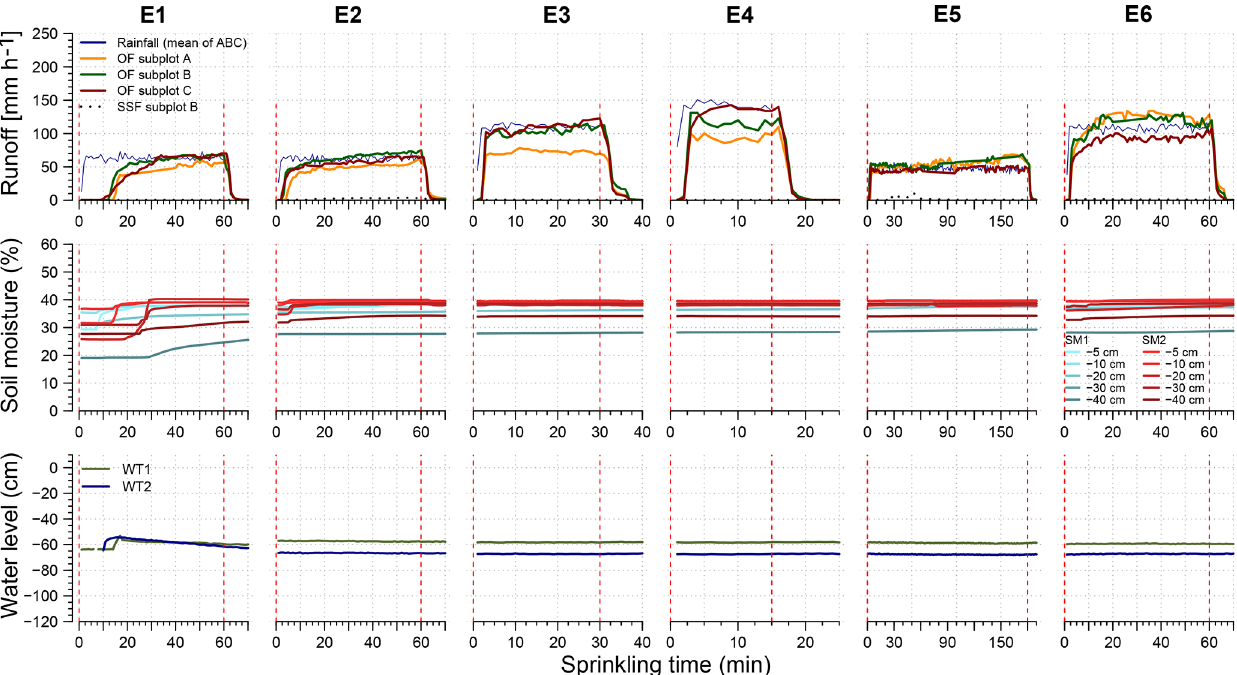
Figure 6. Example for runoff reactions, soil moisture and temporary saturated soil zone for experimental site 20 on a recently harvested corn field for the six individual simulations of extreme rainfall. The runoff hydrograph at subplot A in experiment 3 and subplot A and B in experiments 5 and 6 illustrate measurement errors mentioned in Sect.